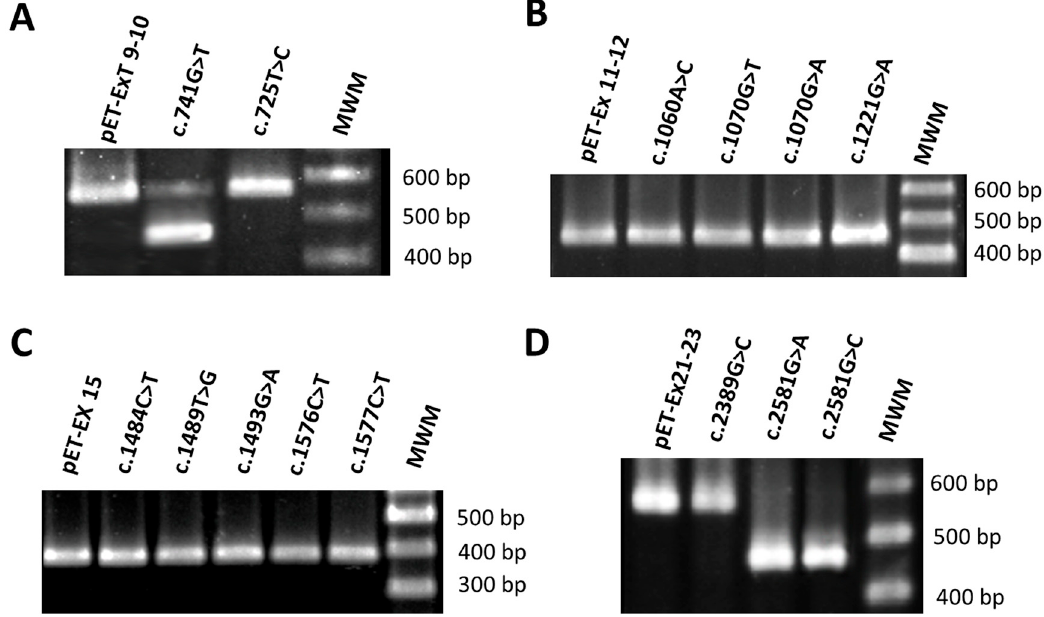
Figure 2. RT-PCR analysis of the spliced transcripts expressed from the OCRL minigenes containing wild-type and mutant exons. ( A ) Of the two mutations introduced in exon 9, only c.741G>T; p.(Trp247Cys) generated an altered mRNA product. ( B ) and ( C ) None of the mutations introduced in exons 12 and 15 showed alterations in splicing. ( D ) Mutations c.2581G>A; p.(Ala861Thr) and c.2581G>C; p.(Ala861Pro) in exon 23 resulted in altered mRNAs. MWM: Molecular weight marker.